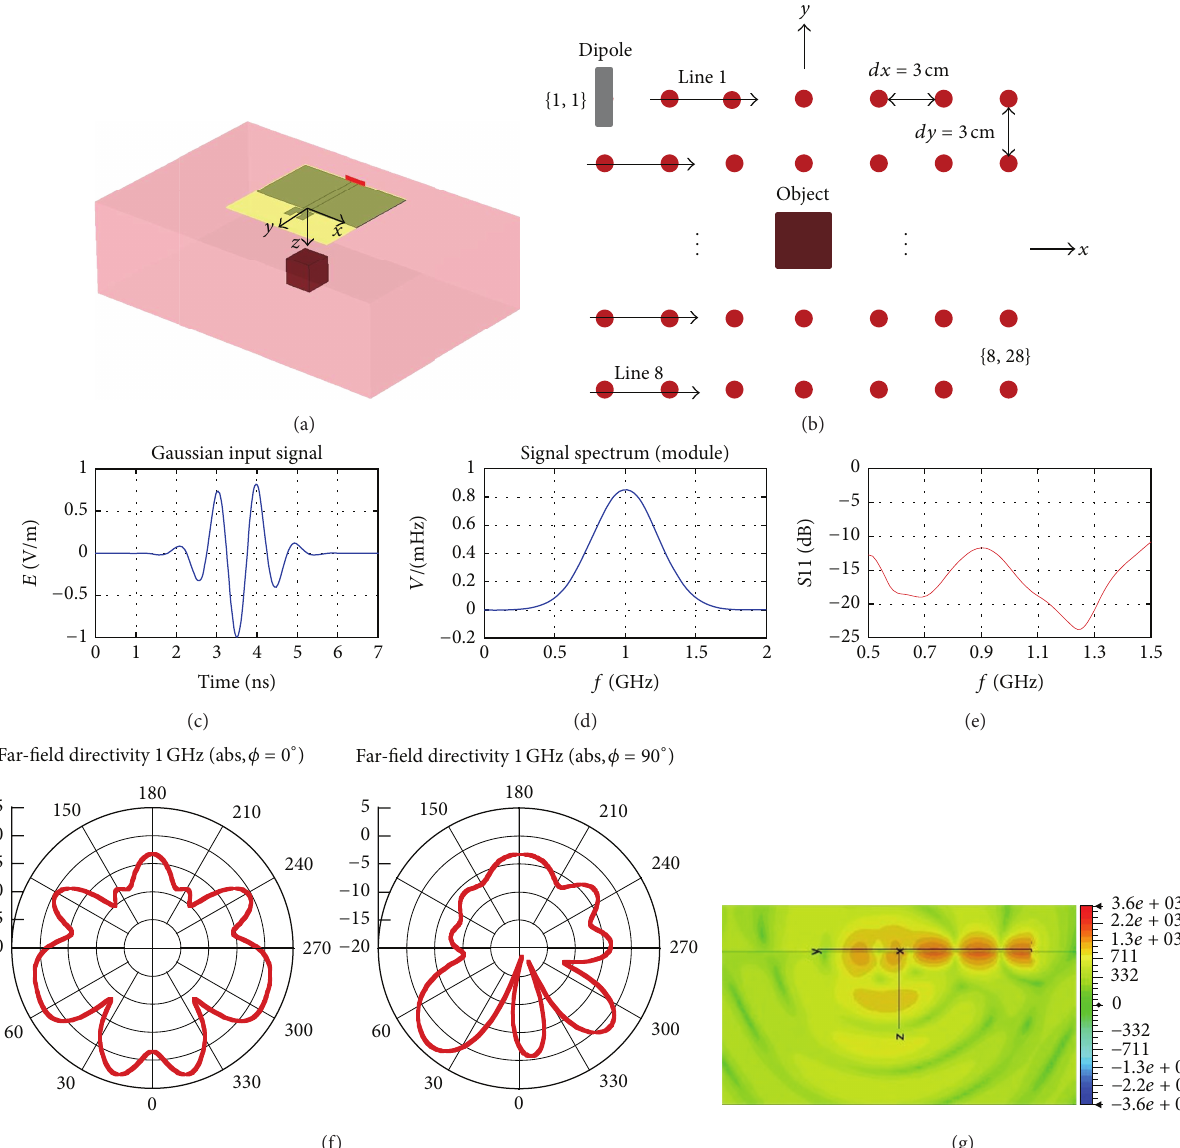
Figure 1: The basic GPR setup analyzed by means of the CAD tool for the forward scattering problem: (a) 3D view of the simulation environment, including a wideband printed monopole antenna placed on the air/ground interface and a buried scatterer; (b) top view of the antenna scanning domain at the interface, with the coordinate system, the grid points, and the numbering of the scanning lines; (c) simulated waveform of the GPR input signal versus time (ns); (d) magnitude spectrum of the input signal versus frequency 𝑓 (GHz); (e) behavior of the antenna return loss (magnitude of the reflection coefficient in dB) versus frequency 𝑓 (GHz) in the matching range; (f) antenna radiation patterns versus elevation angle 𝜃 in polar form, in the 𝜙 = 0 ∘ (left) and the 𝜙 = 90 ∘ (right) planes (fixed central frequency 𝑓 = 1.0 GHz); (g) section view for a fixed 𝑥 (central 𝑦𝑧 plane) of the magnitude of the electric-field distribution generated by the antenna at the interface in near-field conditions (same fixed frequency 𝑓 = 1.0